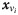
The overall model structure of the proposed method.The line in the bottom of the figure indicates a genome sequence where observed variants are in green square and unobserved variants are in white square. Forward and backward RNNs are built on the observed variants. xvi is the input feature vector of the forward and backward RNNs for observed variant vi. fi is the vector from the concatenation of the output of the forward RNN for observed variant vi and the output of the backward RNN for observed variant vi+1. yui is a binary variable indicating the allele for unobserved variant ui.